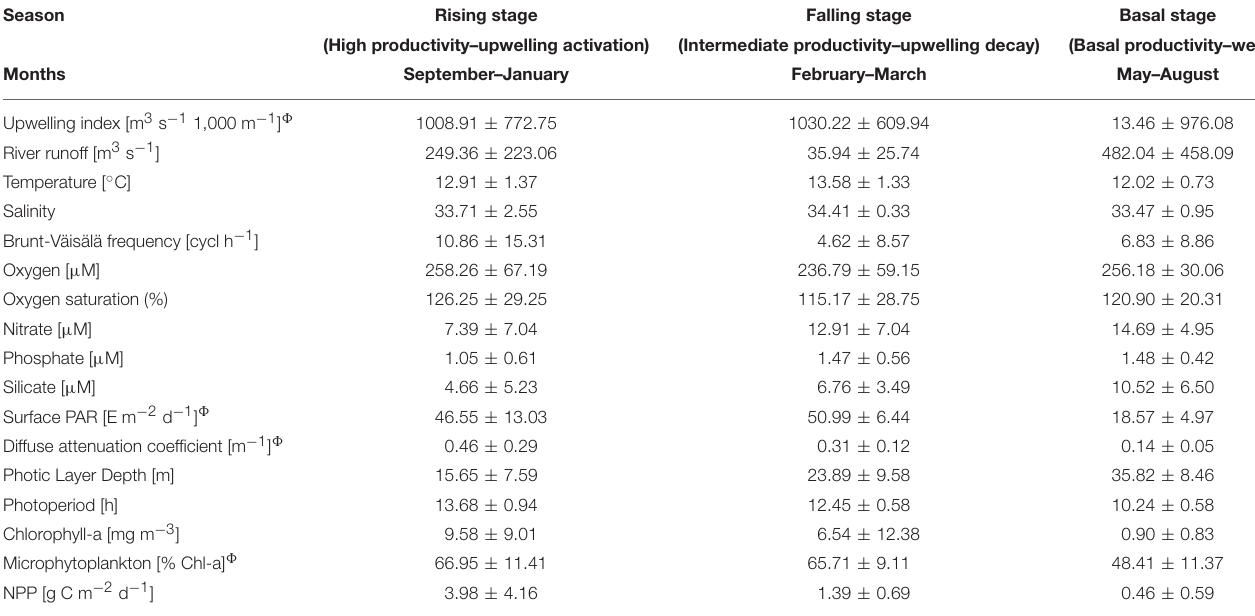
TABLE 4 | Summary of bio-oceanographic conditions during three different periods of the year off central Chile (mean ± standard deviation). Season Rising stage Falling stage Basal stage (High productivity–upwelling activation) (Intermediate productivity–upwelling decay) (Basal productivity–wet)